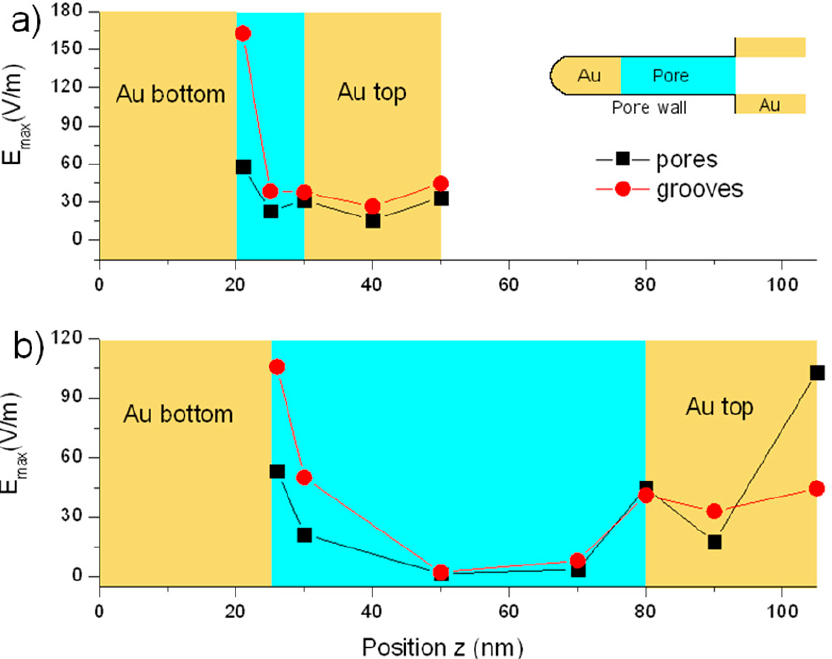
Figure 5. E max values derived from simulations performed at different height z within the APA-Au structure. Total thickness is APA thickness + Au coating thickness (25 nm for tAPA and 20 nm for utAPA). ( a ) 30 nm-thick APA; ( b ) 80 nm-thick APA. The coated Au has penetrated the APA and reached the bottom of the pores, as shown in the inset to ( a ). The black curves correspond to a pore arrangement similar to the one of tAPA (pores) while the red ones correspond to the morphology of utAPA (grooves).